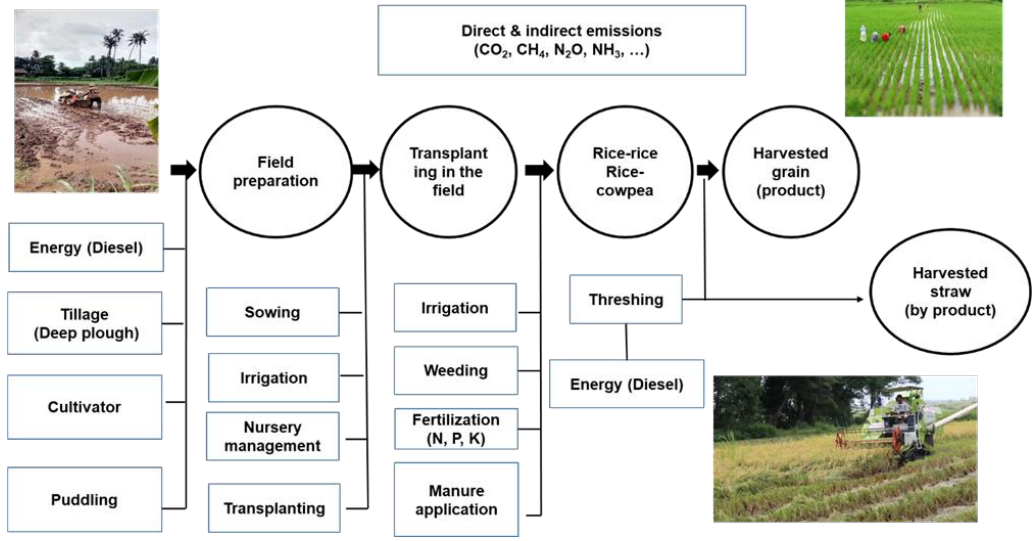
Figure 1. LCA Framework and system boundaries of rice – rice and rice – cowpea systems.